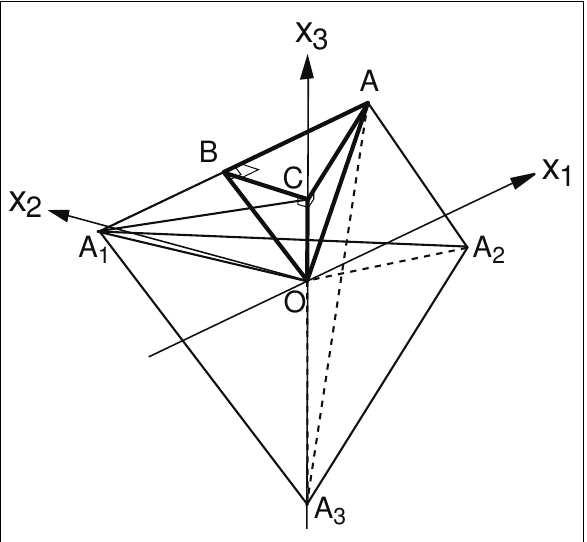
Figure 1. Barycentric eigenvalue space. In the principal tetrahedron OABC , for ordered eigenvalues, O represents a perfect depolarizer; A represents a deterministic system; B represents a system with two equal nonzero eigenvalues; and C represents a system with three equal nonzero eigenvalues. Each of the triangular faces of OABC is a right-angled triangle. For unordered eigenvalues, the regular tetrahedron AA 1 A 2 A 3 contains all physical states of depolarization, with λ 1 = λ 2 = λ 3 = 0 at A , etc. The principal tetrahedron is 1/24 of the volume of the regular